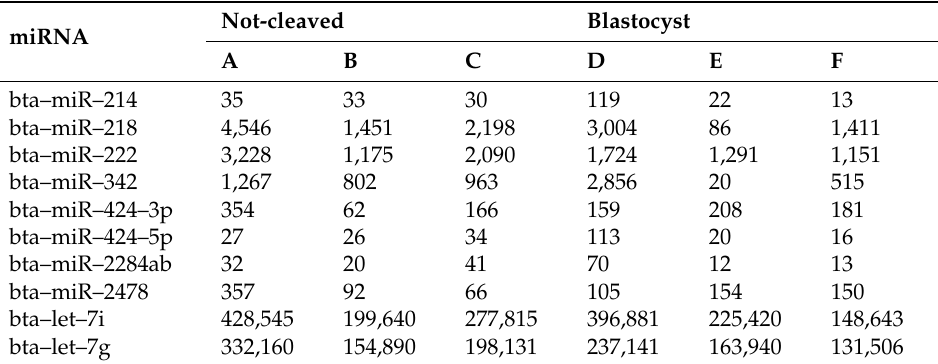
Table 3. Sequencing counts of chosen miRNAs.